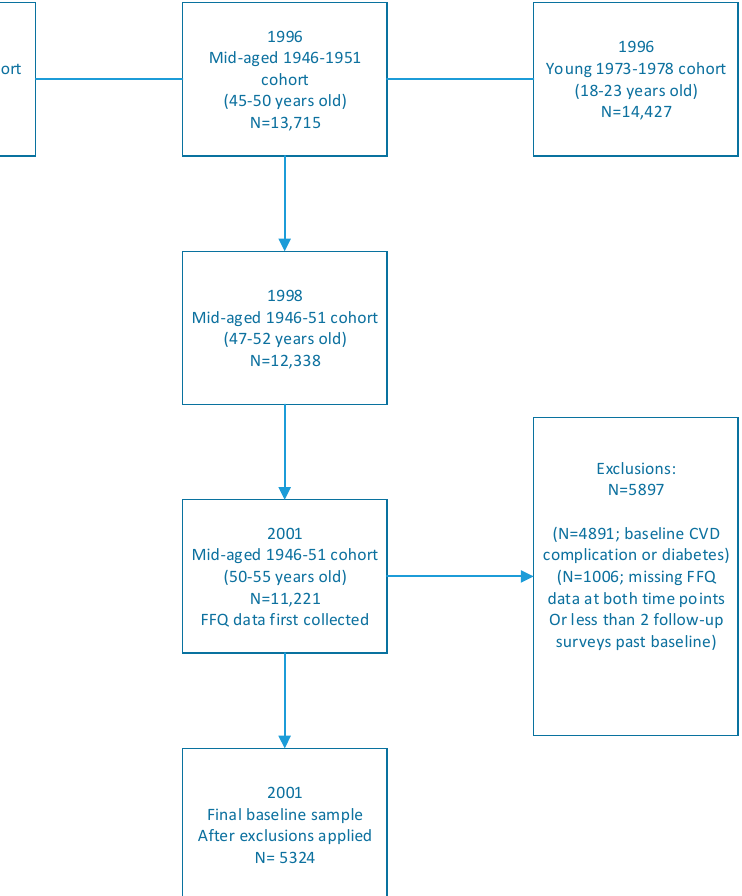
Figure 1. ALSWH: 1946–1951 Cohort Participant Flow Chart.